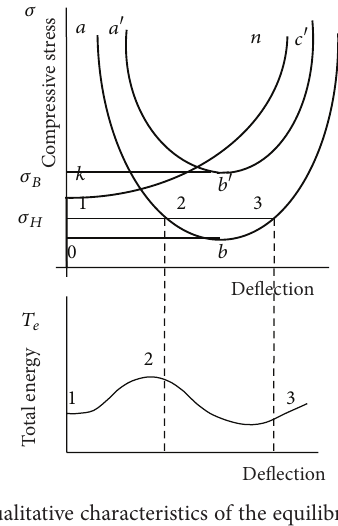
Figure 1: Qualitative characteristics of the equilibrium state of the pipeline at the loss of stability.